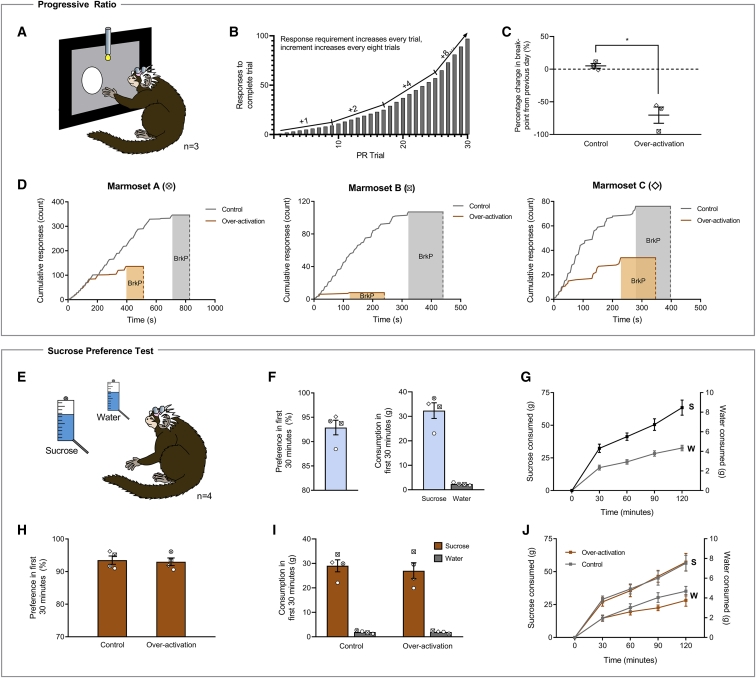
sgACC/25 Over-Activation Impairs Reward Motivation on a Progressive-Ratio Schedule of Reinforcement but Has No Effect on Sucrose Preference or Sucrose ConsumptionRelevant graphs show mean ± SEM (n = 3 for progressive ratio; n = 4 for sucrose preference). S, sucrose; W, water.(A) Marmosets were trained to press a circular stimulus on a touchscreen to earn milkshake reward under increasing response demands until breakpoint was reached (2 min with no response).(B) Task design. The response increment from trial n to n+1 starts at +1 and doubles every eight trials until a maximum increment of +8 (trials 1–8, responses 1–8; trials 9–16, responses 10–24, etc.).(C) sgACC/25 over-activation by reducing glutamate reuptake (DHK) decreased the number of responses marmosets made before breakpoint was reached (two-tailed paired t test, p = 0.042).(D) Response profiles in control and over-activation sessions for each animal. The 2-min timeout period signifying the breakpoint (BrkP) is shaded.(E) In the sucrose preference test, marmosets were presented with two identical bottles in their home cage: one containing sucrose, and one containing water. A single session lasted 2 hr with measurements taken every 30 min. The first 30-min time point was of a priori interest owing to the rapid actions of the intracranial infusions.(F) Prior to experimental manipulations, marmosets showed a high preference for sucrose during the first 30 min of the session (92.9% ± 1.5%), consuming 32.3 ± 3.2 g sucrose and 2.3 ± 0.2 g water (mean ± SEM).(G) Cumulative consumption profile in the session prior to experimental manipulations. Marmosets consumed significantly more sucrose at every time point measured (solution [water, sucrose] × time point [four, 30-min time bins], F3,9 = 26.97, p < 0.0001; effect of solution, p < 0.0001 at every time point).(H) Compared to a control infusion of saline, over-activation of sgACC/25 by reducing glutamate reuptake had no effect on sucrose preference in the first 30 min of the session (two-tailed paired t test, p = 0.800).(I) Over-activation of sgACC/25 had no effect on sucrose or water consumption in the first 30 min of the session (solution × manipulation, F1,3 = 1.05, p = 0.381; main effect of manipulation, F1,3 = 1.70, p = 0.283).(J) Across the 2-hr session, over-activation of sgACC/25 had no effect on cumulative sucrose or water consumption (solution × manipulation, F < 1, NS).